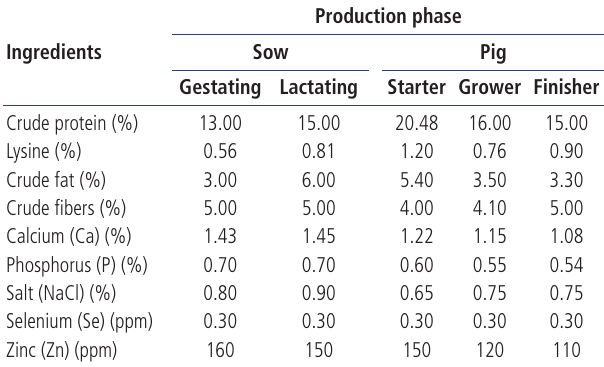
Table 2. Nutritional information of the different types of feed used in the